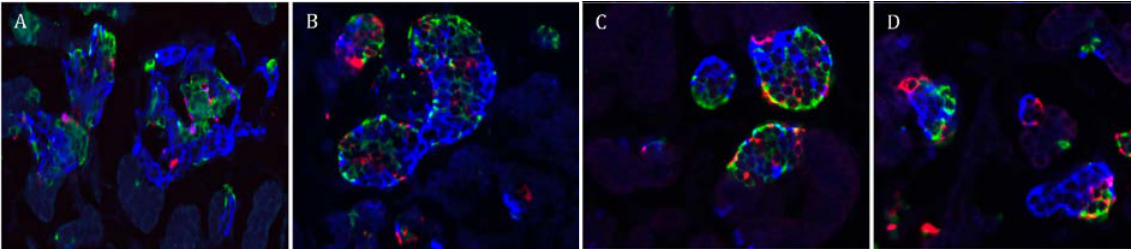
Figure 2. Brain and heart mass relative to fetal mass. Mean brain mass ( A ) and heart mass ( B ) relative to fetal mass (g/kg) are presented for the treatment groups labeled on the x-axis. The treatment groups are presented on the x-axis. Error bars represent the SEM and different superscripts denote statistically significant differences among treatment groups ( p < 0.05).